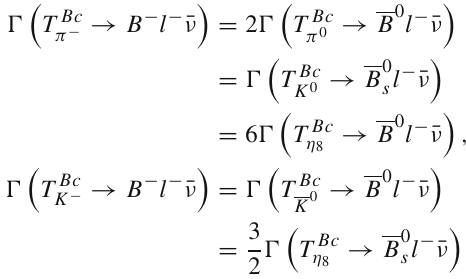
Table 1 Amplitudes for tetraquark T b ¯ c 8 / T b ¯ c 1 decays into anti-charmed meson, a light meson or J /(cid:12) Channel Amplitude Channel Amplitude